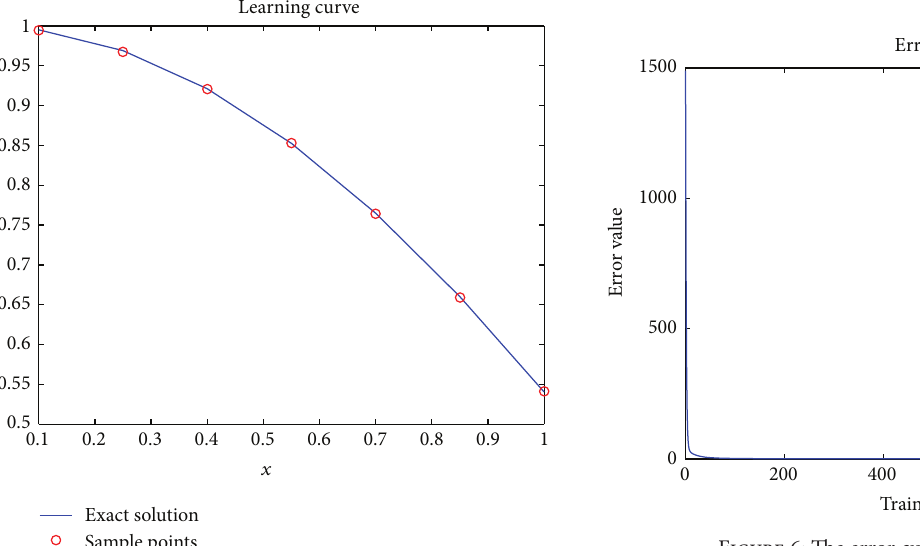
Figure 4: The learning curve for Example 2.